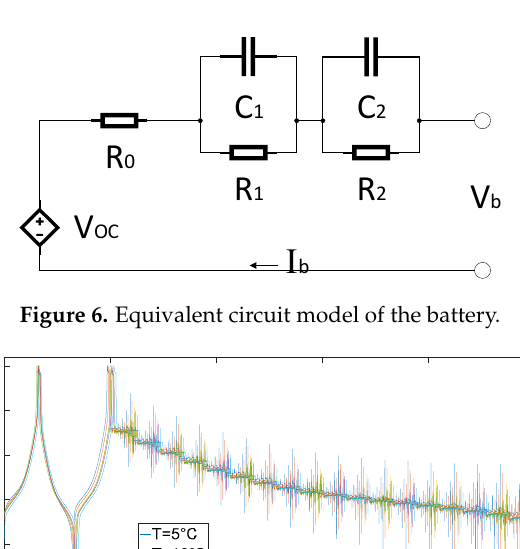
Figure 5. The lithium-ion battery cell cross-section.